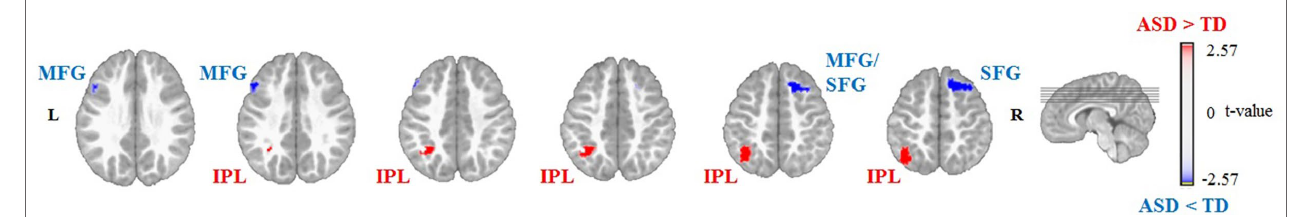
FIGURE 4 | Source localization of group differences for Group Map 3 showing decreased activation of the left and right middle frontal gyrus (MFG) and right superior frontal gyrus (SFG), and increased activation of the left inferior parietal lobule (IPL) in the autism spectrum disorder (ASD) group (n = 14) compared to the typically developing (TD) group (n = 14) during free viewing of “Trotro” cartoons. The t-values of the unpaired t-test thresholded to P < 0.01 of the randomization test are plotted. L, left; R, right.